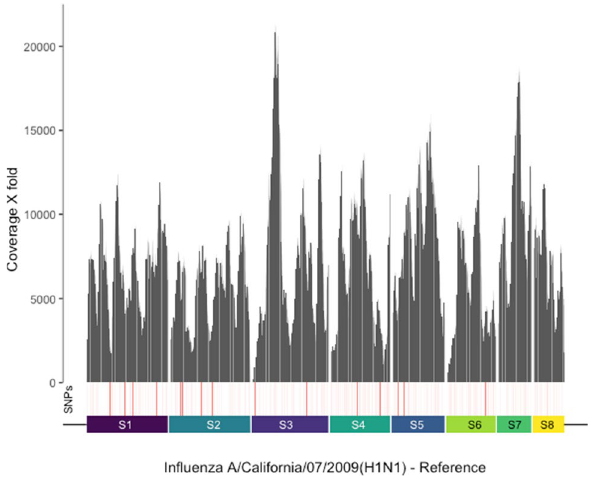
Figure 2. Full genome coverage of co-infecting influenzavirus. Coverage plot of sequence reads generated by Twist capture sequencing of the SARS-CoV-2 case specimen nCoV_240, aligned to the influenzavirus A reference genome across eight different segments (S1-S8). Depth represented as X fold coverage. Single nucleotide polymorphisms (SNPs) detected at positions across the genome are indicated in red, greater intensity of red indicates higher %